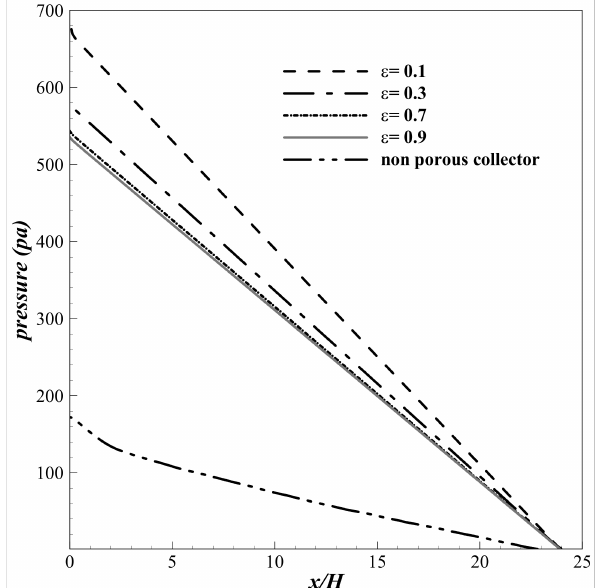
Figure 8. The variation in pressure across the collector versus the length to height ratio for the different porosity coefficients at a permeability of 5 × 10 − 6 m 2 , with u in = 2